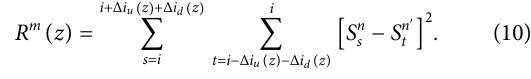
FIGURE 6 | Steps of the proposed pixel fusion